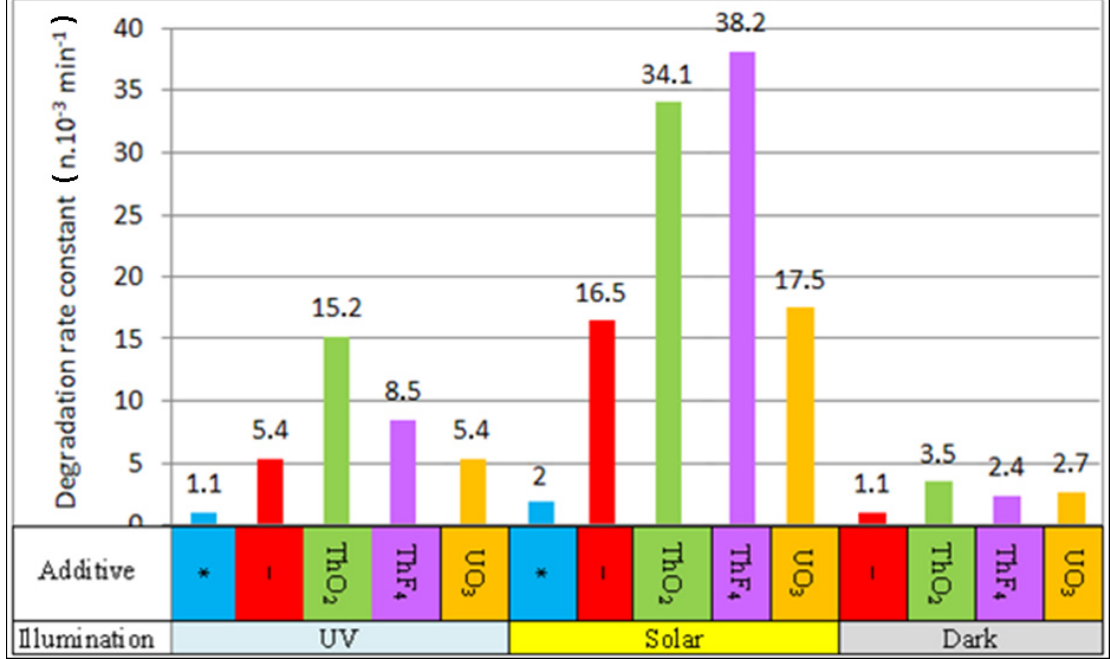
Figure 5. Degradation rate constant at 1% content of additives in the composites: * - photolysis, only; “-“ pure TiO